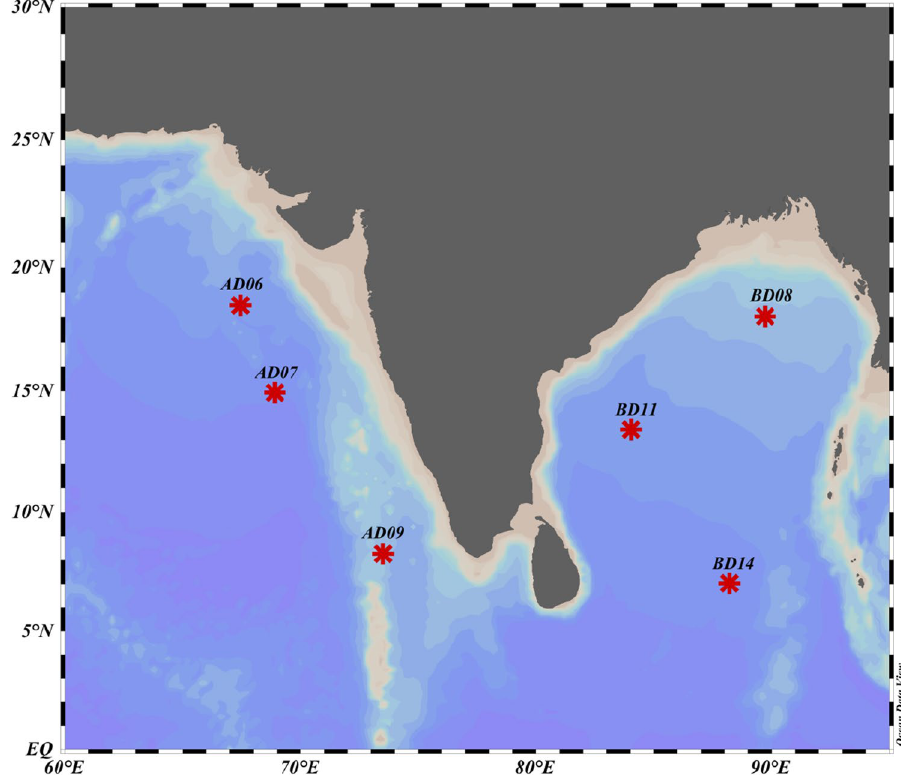
Figure 1. Map showing locations of deep water moored buoy locations in the North Indian Ocean (NIO).